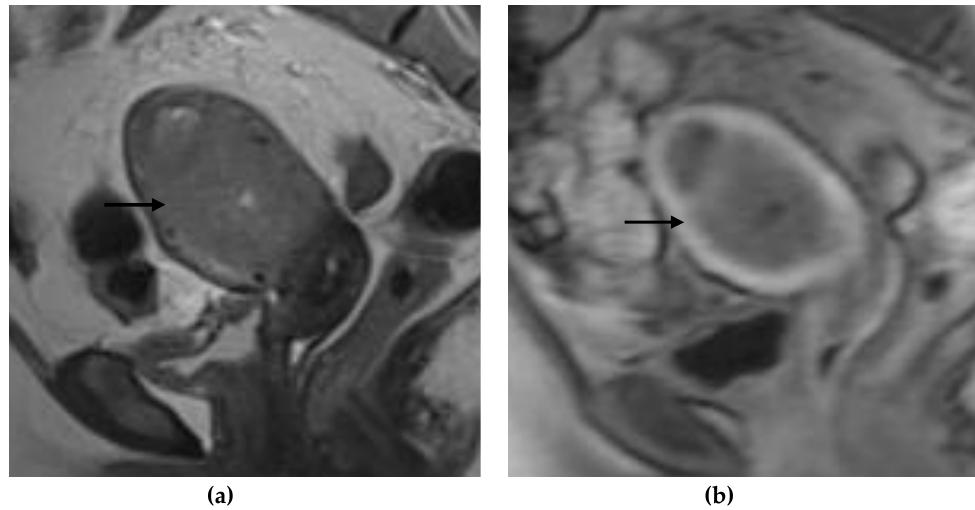
Figure 4. Representative MRI images of endometrial carcinoma of a false-positive case in a 67-year- old postmenopausal woman. ( a ) Sagittal T2WI MRI image shows a slightly hyperintense lesion with disruption of the junctional zone (arrow). ( b ) DCE-MRI image shows a hypointense lesion with thinning of the myometrium and ≥ 50% myometrial invasion. Subendometrial enhancement was not visible. However, the histopathological result revealed <50% myometrial invasion.